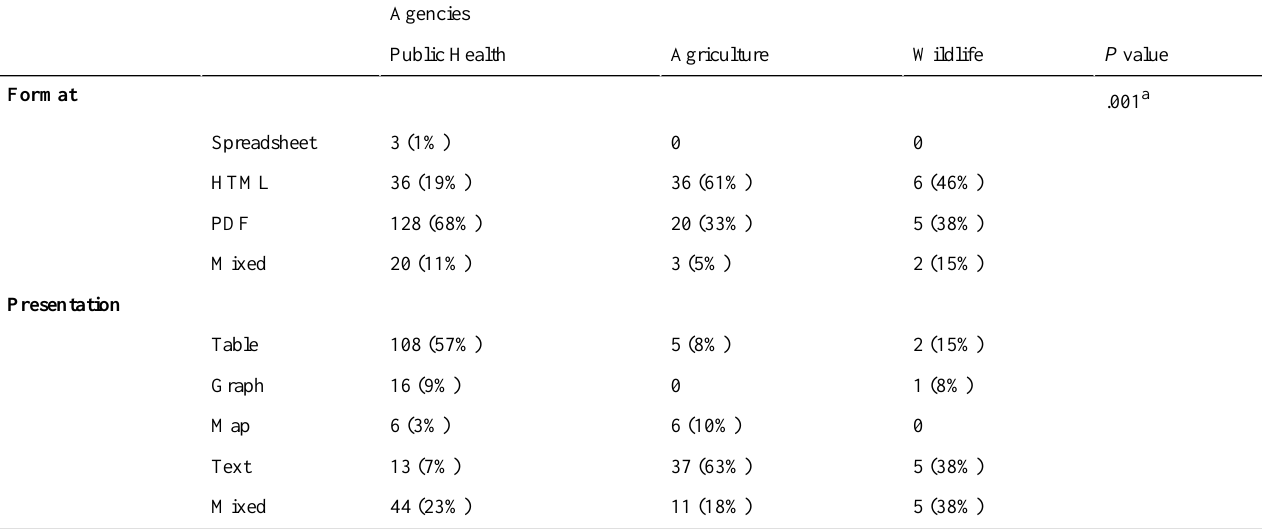
Table 2. Comparison by agency type of the number of states that provided zoonotic viruses data on websites by format and presentation, 2000-2012 ( P values determined by Fisher’s Exact test; percentages might not add to 100% due to